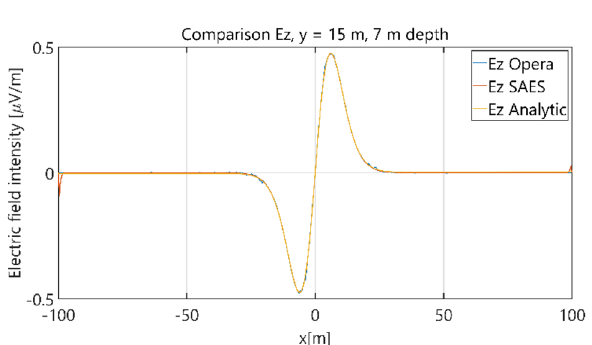
Figure 13. Distribution of E z component ( y = 0 m, z = − 7 m, case I).